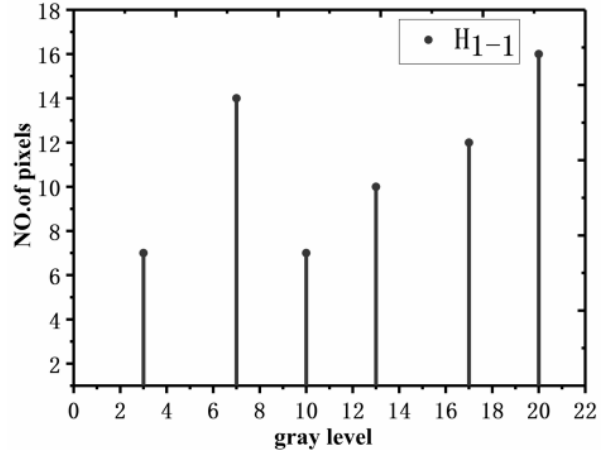
Figure 3. The uniform distribution of histogram H 1-1 .